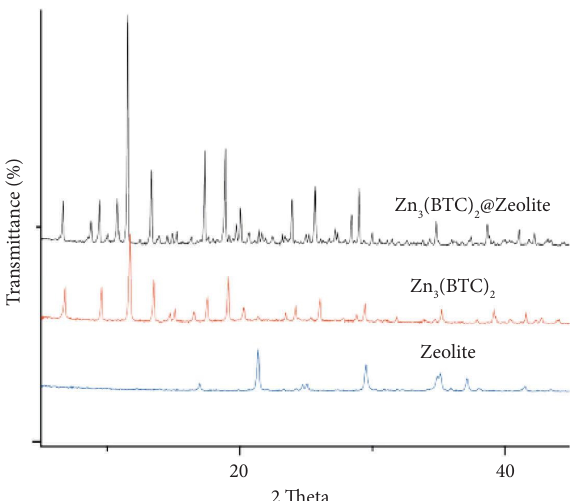
Figure 25: XRD pattern of zeolite, [Zn [Zn 3 (BTC) 2 ] adopted from [33].